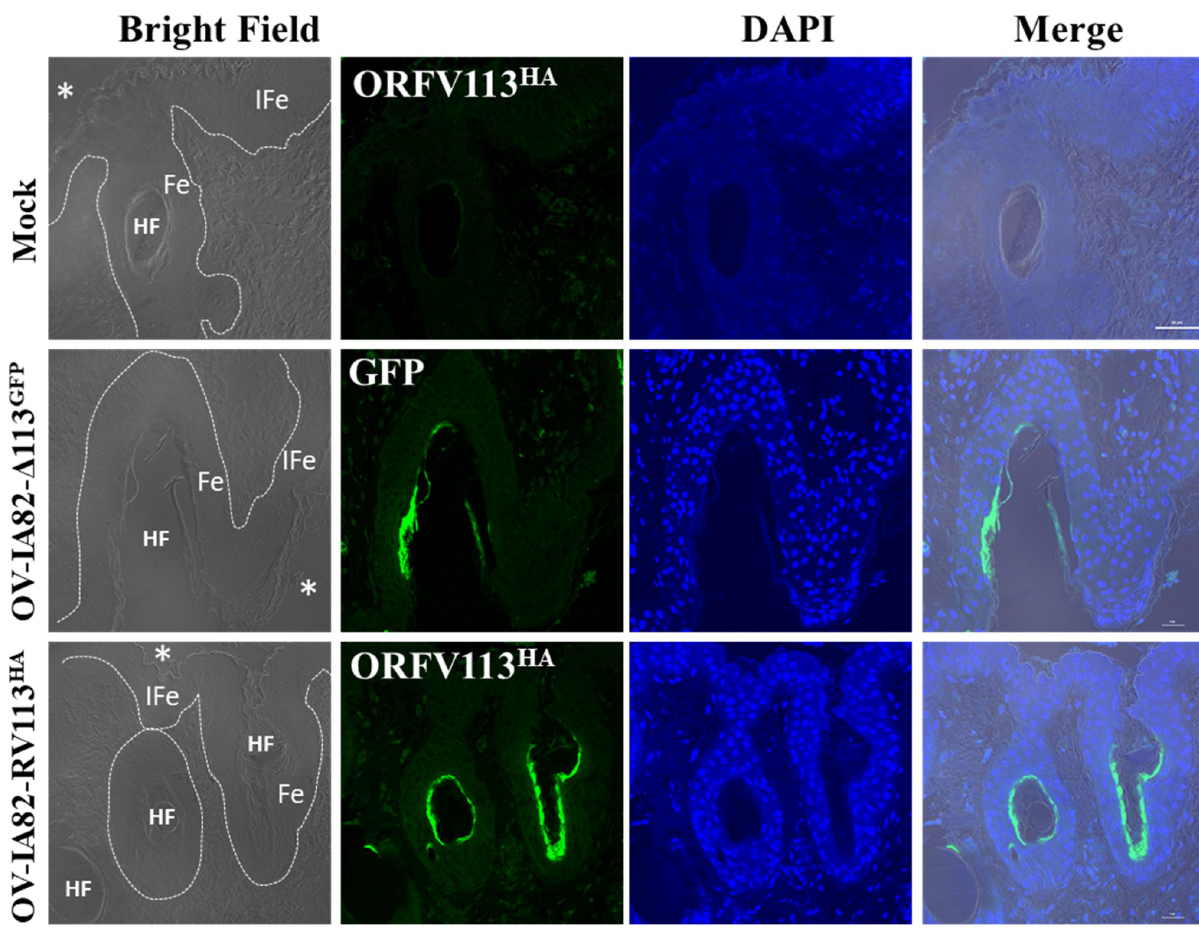
Fig 11. ORFV infects the infundibular region of hair follicles at early times p.i. Sheep were scarified in the inner side of the thighs and infected with viruses OV-IA82 Δ 113 GFP or OV-IA82RV113 HA , or mock infected, and tissue samples collected at various times post-infection. Shown are representative confocal microscopy images at 24 h post-infection. � , outer side of the skin; dashed line, location of the basal membrane of epithelium; HF, lumen of hair follicles at the level of infundibular region; IFe, interfollicular epidermis; Fe, follicular epidermis; Green: GFP or ORFV113 HA , Blue: DAPI. Magnification